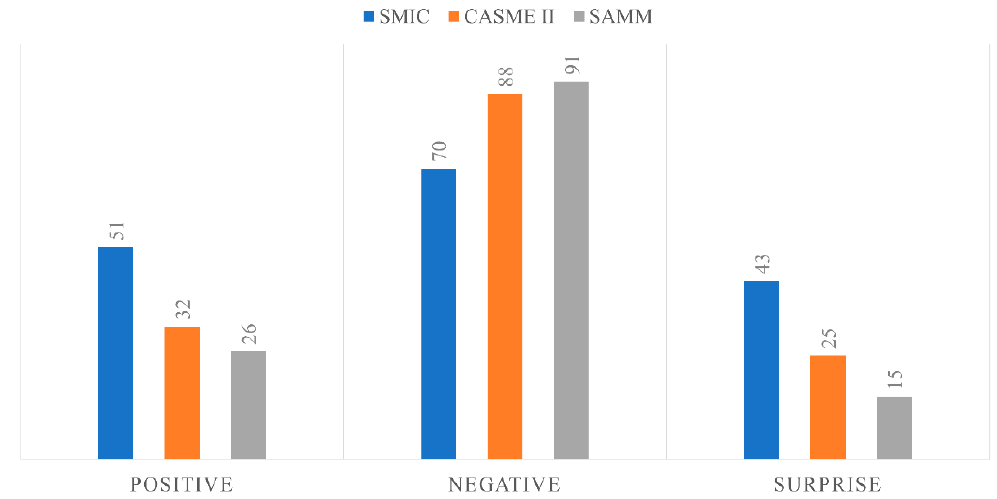
Figure 3. ME datasets.